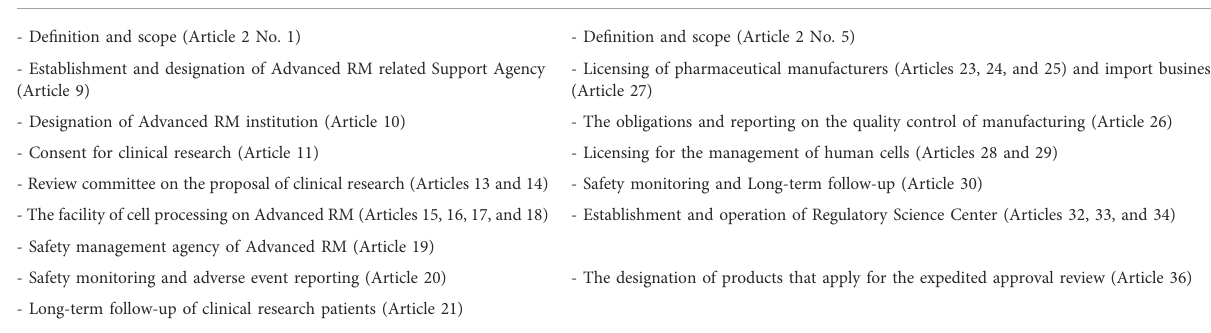
TABLE 2 The structure of the ARMAB Act (Ministry of Health and Welfare,